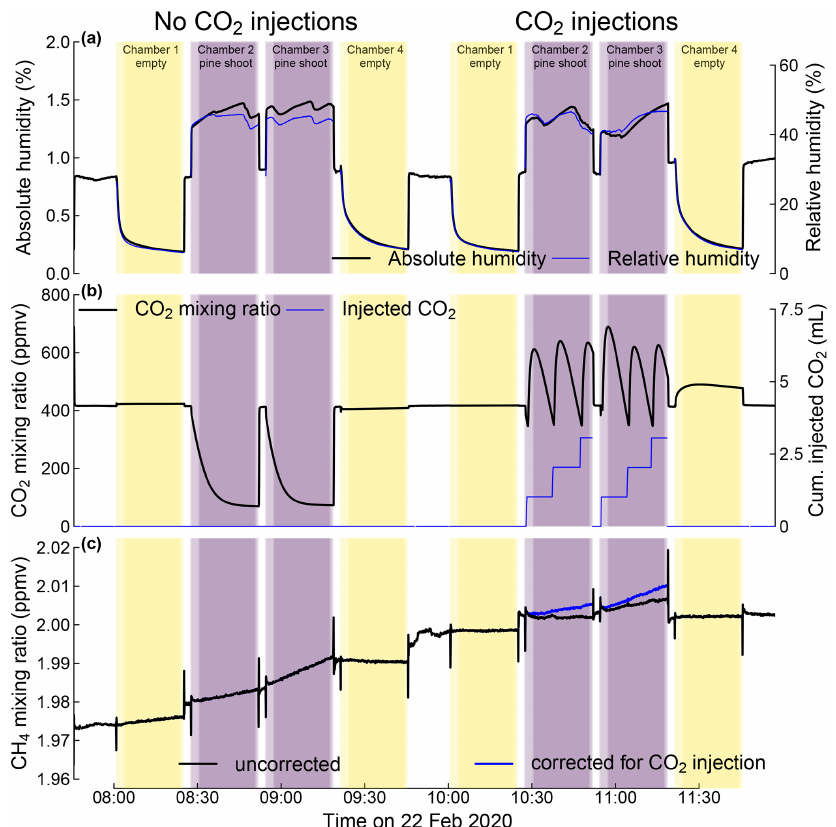
Figure 5. Mixing ratios of water (a) , CO 2 (b) , and methane (c) during static chamber closures of four shoot chambers in the greenhouse system. Chambers 2 and 3 each contained a shoot of a 2-year-old pine sapling; chambers 1 and 4 were kept empty as blank controls. The figure depicts two sets of chamber closures that were conducted without and with CO 2 injections to compensate for plant CO 2 uptake. Black lines in panels (a) to (c) represent the measured mixing ratios of water (a) , CO 2 (b) , and methane (c) , respectively. The blue line in panel (b) indicates the cumulative amount of CO 2 injected since the beginning of the chamber closure, expressed as the equivalent mixing ratio in the chamber (right-hand axis). The blue line in panel (c) indicates the methane mixing ratio after correcting for dilution by the injected CO 2 (see text). Shaded areas indicate times when chambers with or without shoots were connected to the static chamber module with darker colours indicating times used to calculate flux rates. The analyser was connected to an ambient air inlet between these closure times. The depicted data were measured on 22 February